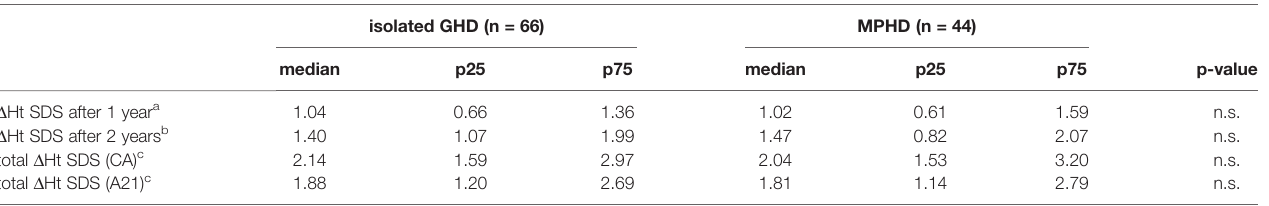
TABLE 3 | Response to GH treatment in isolated GHD versus